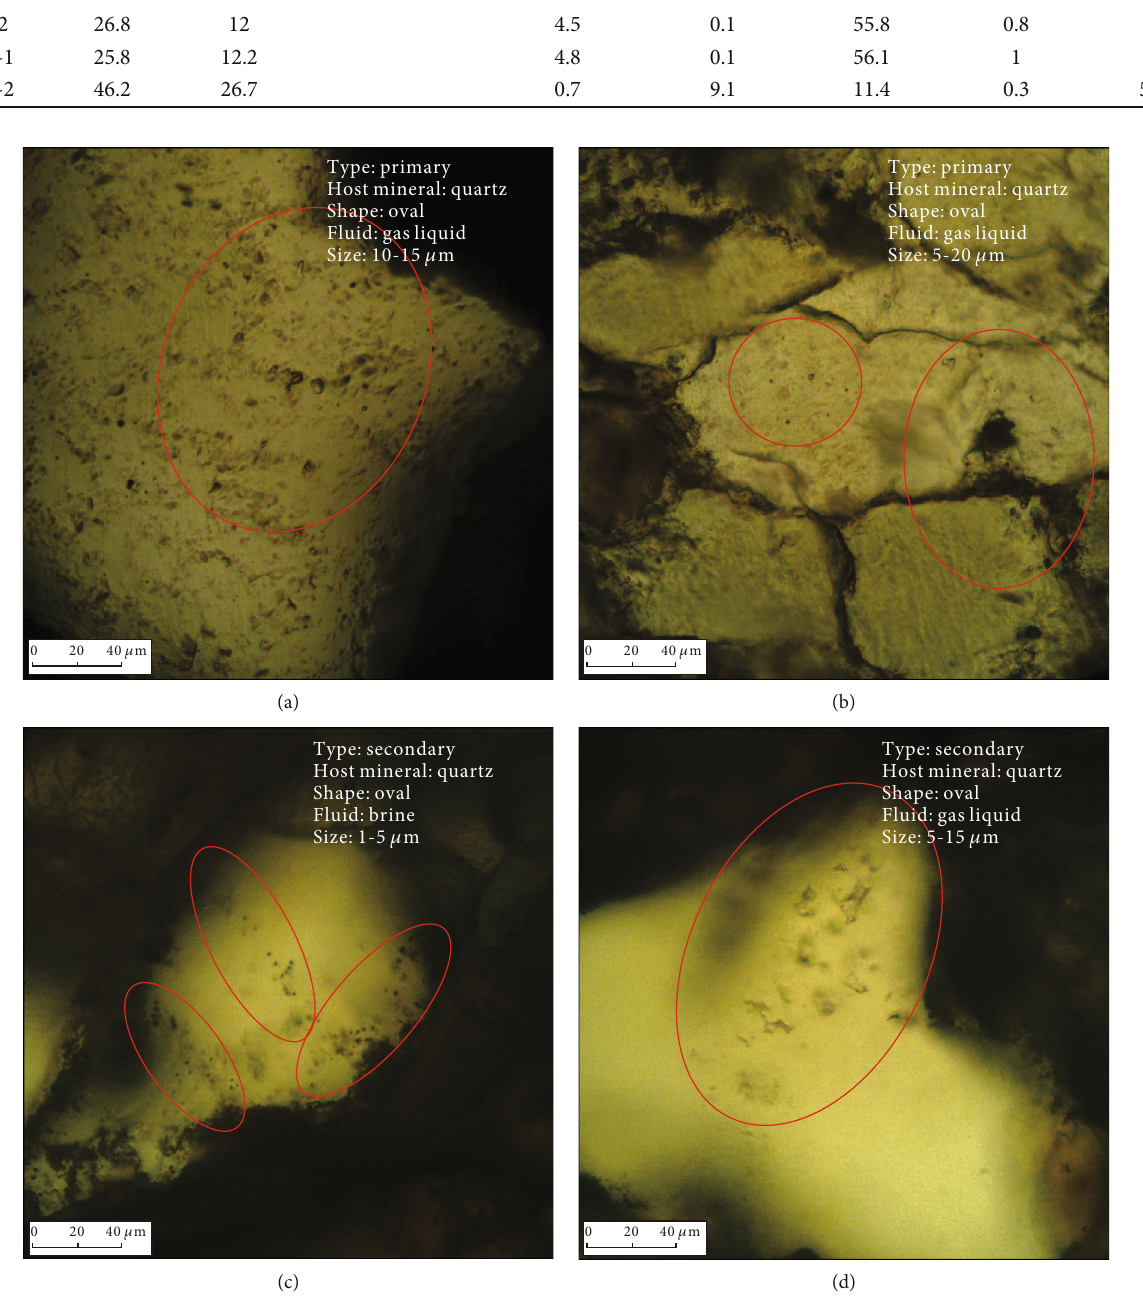
Figure 6: Characteristics of the typical fl uid inclusions within the Longtan tight sandstones in west Guizhou: (a) primary gas-liquid inclusion under polarized light for the YV-1-1 sample; (b) primary gas-liquid inclusion under polarized light for the YV-1-3 sample; (c) secondary brine inclusion under polarized light for the HV-3-1 sample; and (d) secondary gas-liquid inclusion under polarized light for the HV-3-1